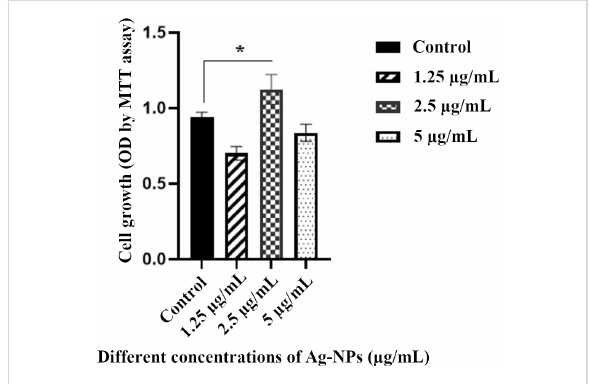
Figure 4: Proliferation rates of cardiomyogenically differentiated BM-MSCs in the presence of different concentrations of Ag-NPs for 14 days, using MTT assay (* p < 0.05 compared with control